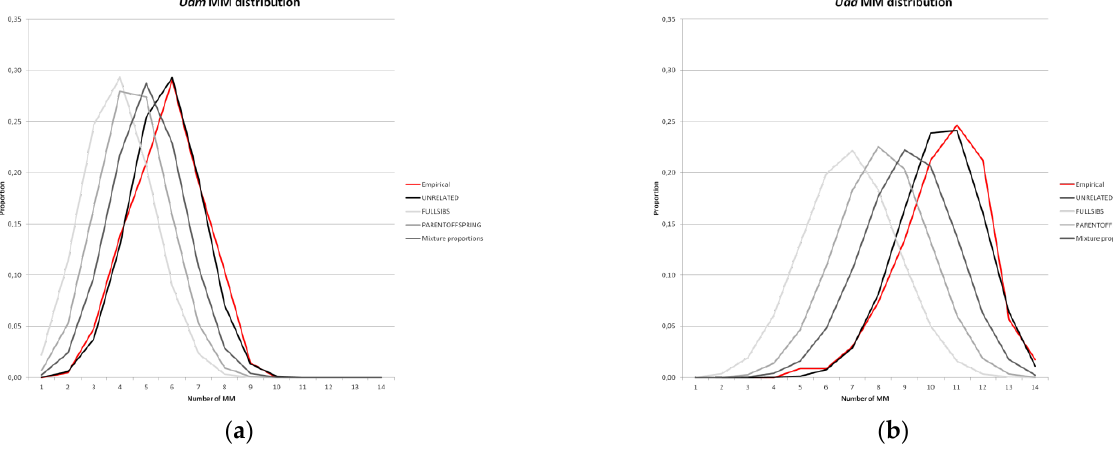
Figure 2. Mismatch probability distributions in Italian brown bear populations. Results are shown for the NEW STR set; the X-axis reports the number of mismatches and the Y-axis shows the probability: ( a ) U. a. marsicanus ( Uam ) population; ( b ) U. a. arctos ( Uaa )